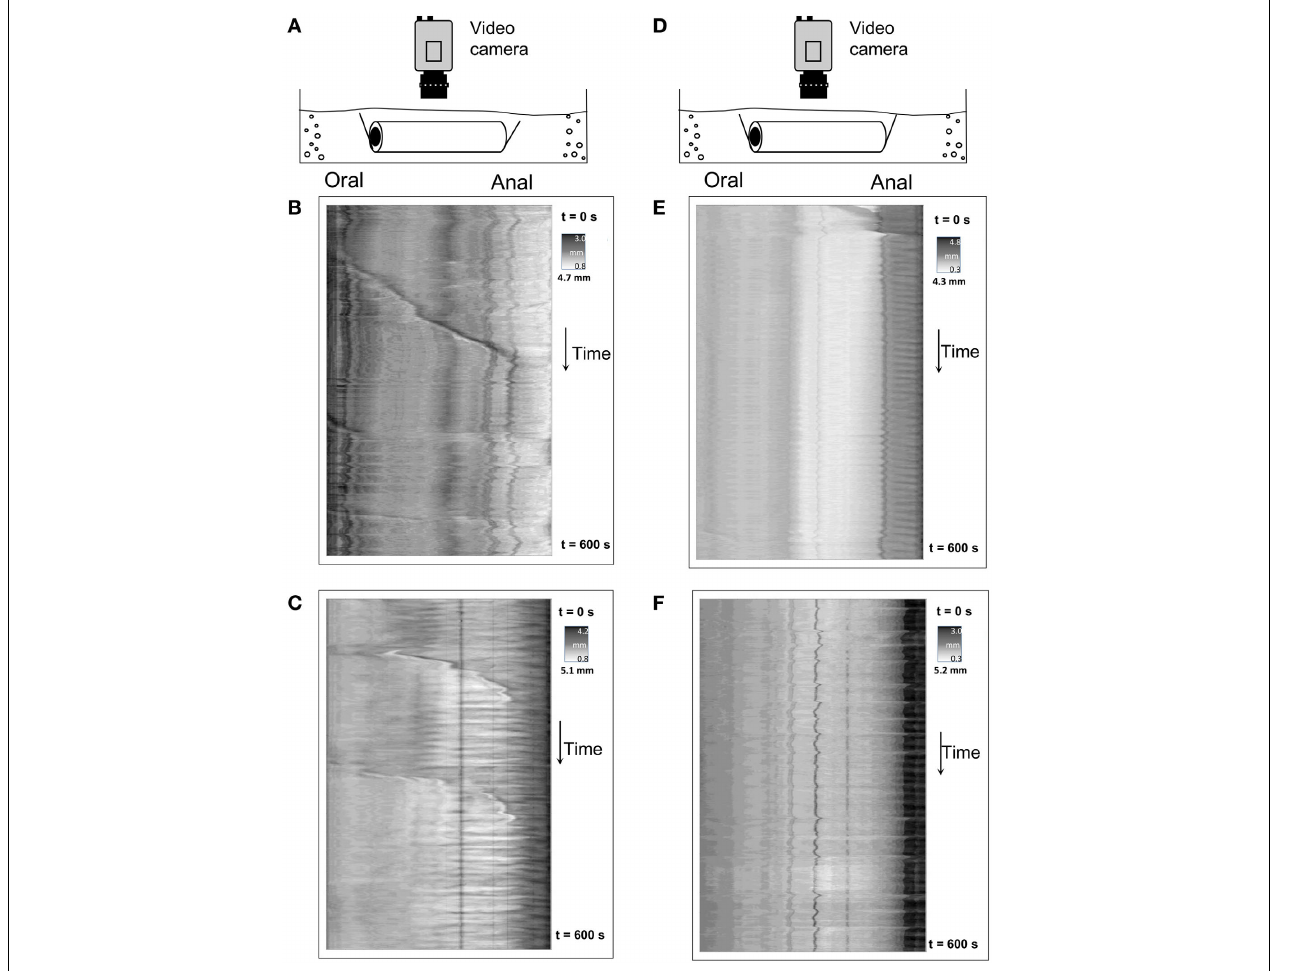
FIGURE 3 | Spatiotemporal maps of colonic wall diameter showing CMMCs in 4 separate empty colonic preparations. (A,D) are diagrammatic representations of the empty preparations, with the video camera mounted directly above each preparation. (B,C) Show